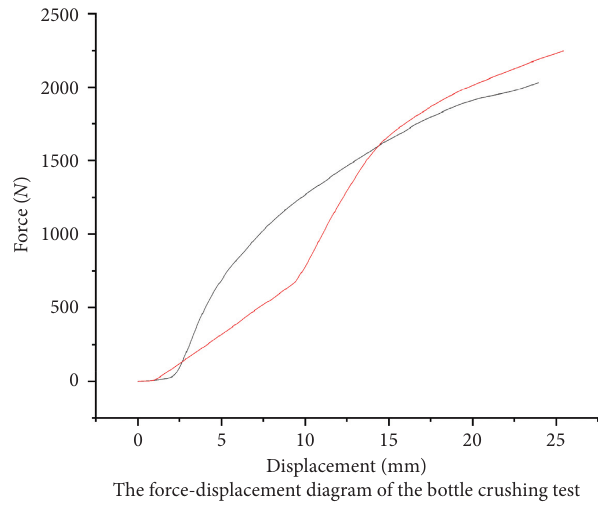
Figure 5: Bacterial bottle entirely squeezed.